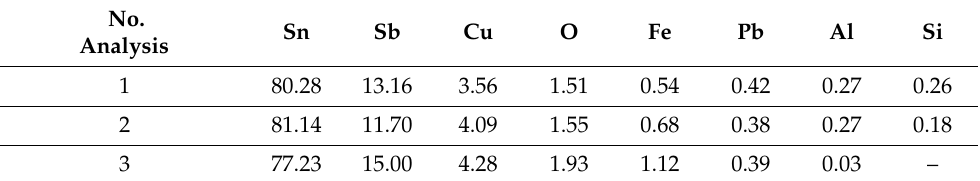
Table 9. EDX analysis of selected zones from Figure 4e of wear surface of B83 babbitt at a load of 60 N, mass norm., %.